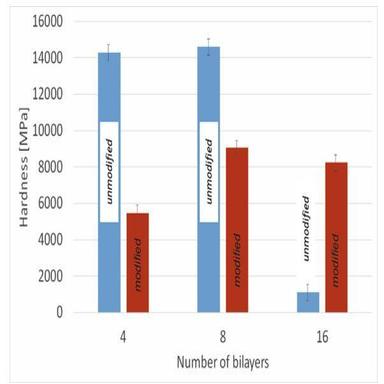
Micro-hardness test results of the PTFE + SiO2/silicone multilayer coating on the PEEK substrate with different numbers of interlayers, with and without an additional silicone top layer.